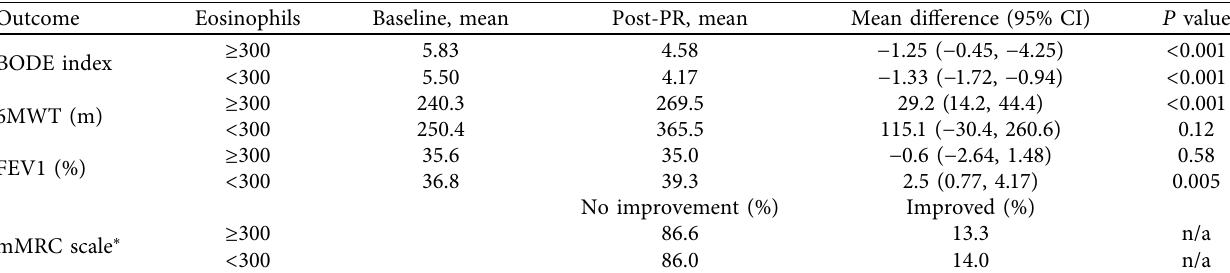
Table 2: Within-group change on outcomes postpulmonary